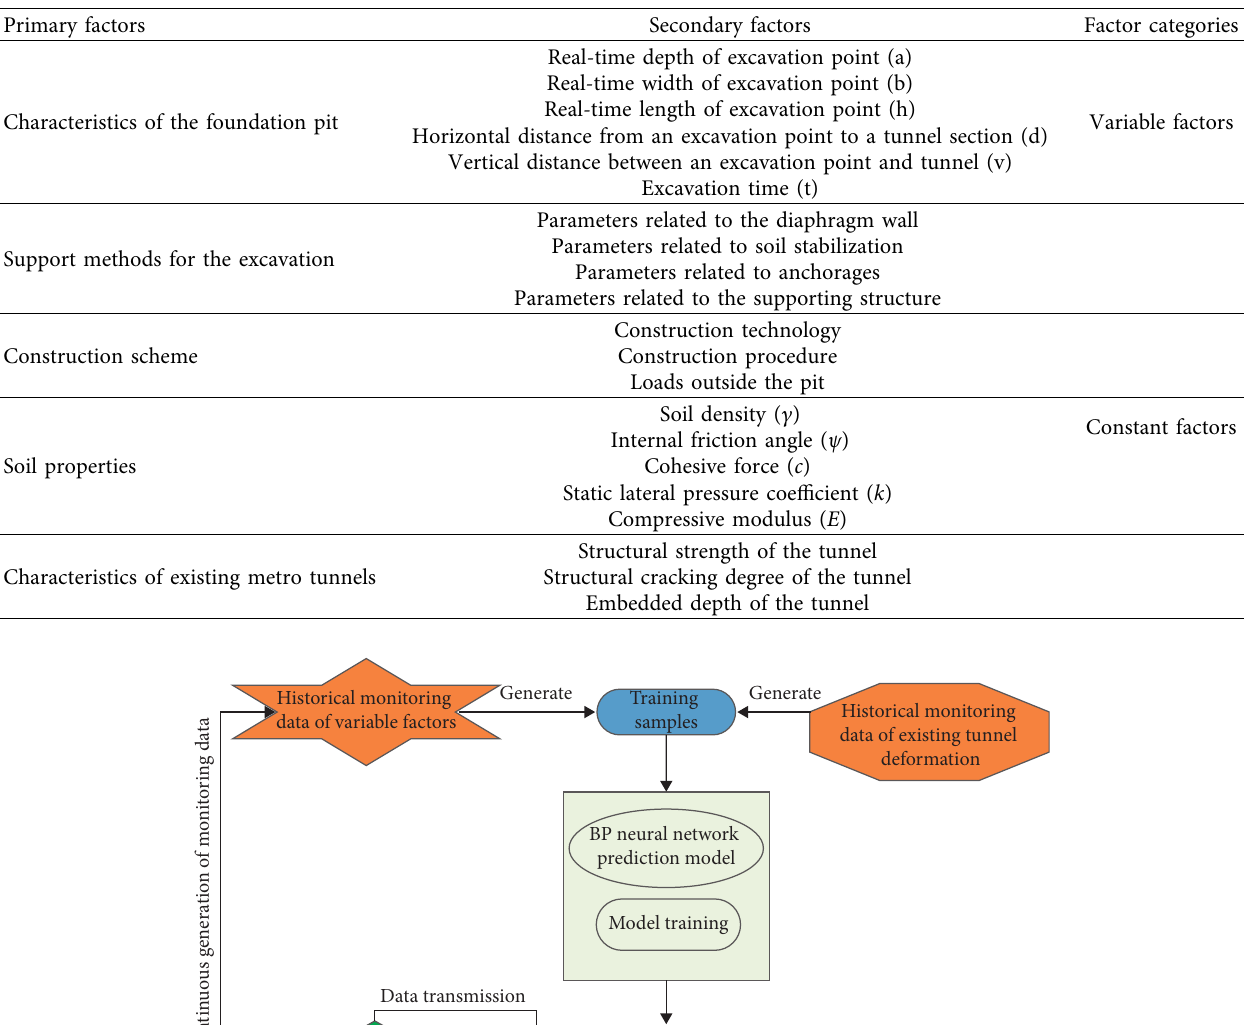
Table 1: Summary of factors affecting safety risks.